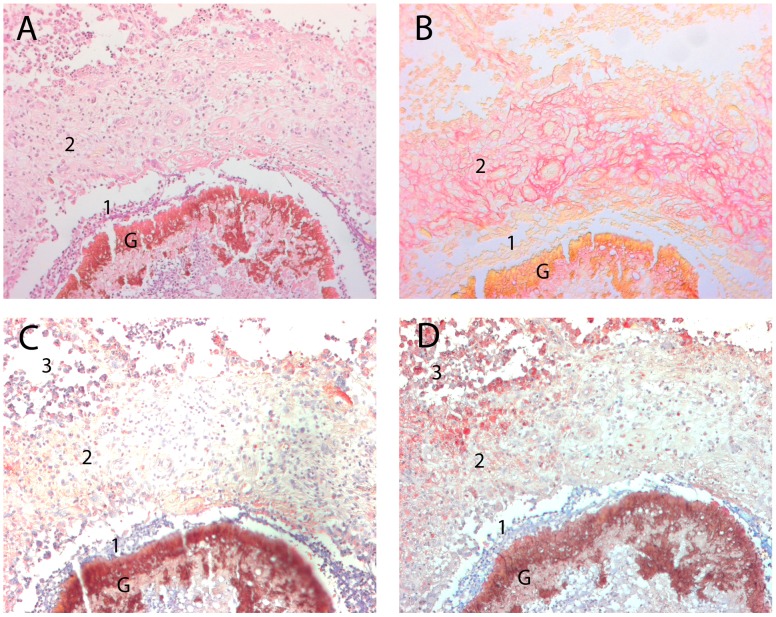
Collagen deposition and MMP-2 and MMP-9 expression around the M. mycetomatis grain.In this figure a representative picture of the M. mycetomatis grain insight the subcutaneous tissue from one particular patient is shown. In panel A, a HE staining is performed. The grain (G) and two different zones surrounding the grain are clearly visible (1,2). Zone 1, representing the neutrophil zone is relatively small around this typical grain. In zone 2, histocytes, capillaries, lymphocytes, plasma cells, fibroblasts and some macrophages are seen. In panel B, a Sirius red staining of the same area is shown. As is seen on this slide, collagen (coloured red) is mainly seen within zone 2. In panels C and D, MMP-2 and MMP-9 are detected by immunohistochemical staining, respectively. MMP-2 and MMP-9 positive cells are stained red, as a counterstaining hematoxylin is used. Relatively little MMP-2 positive cells were noted in the rim of zone 2, outside the layer where the collagen deposition was seen in panel B. MMP-9 staining was more heavily. Some cells in zone 2 stained positive for MMP-9, but more positive cells were seen at the rim of this zone (zone 3). No MMP-2 expression was noted in zone 1 surrounding the grain.